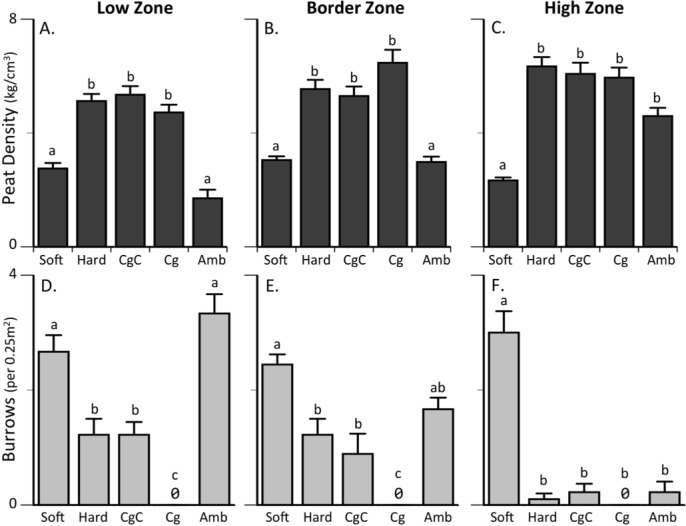
Peat density and burrow counts.Substrate hardness (kg/cm3) and associated burrow counts (within 50x50cm quadrat) in exposed softened peat (Soft), exposed hard peat (Hard), procedural cage control (CgC), consumer exclusion cage (Cg) and ambient (Amb) treatments in the low (A, D), border (B, E), and high zones (C, F); all means are shown + SEM. Colors highlight initial differences in substrate hardness; light gray indicates softened substrate, intermediate gray indicates hard substrate transplanted directly from high marsh, and dark gray indicates ambient substrate. Letters show significant differences across treatments as revealed by Tukey’s HSD post hoc analysis with Bonferroni corrected P values.